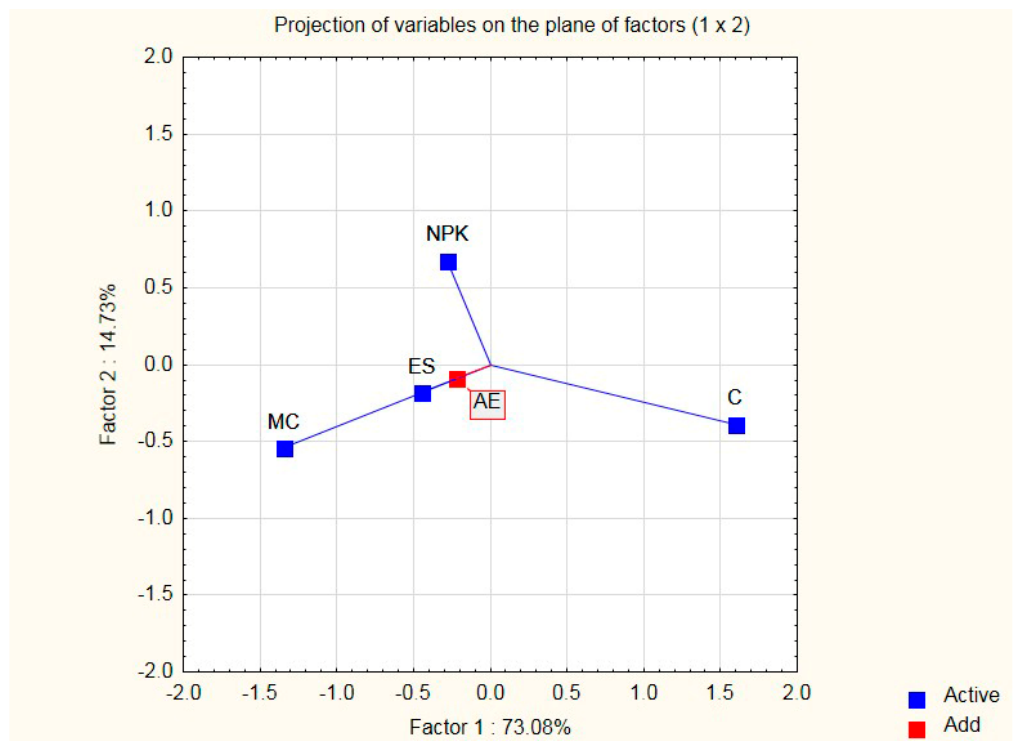
Figure 3. Projection of variables on the plane of variables.